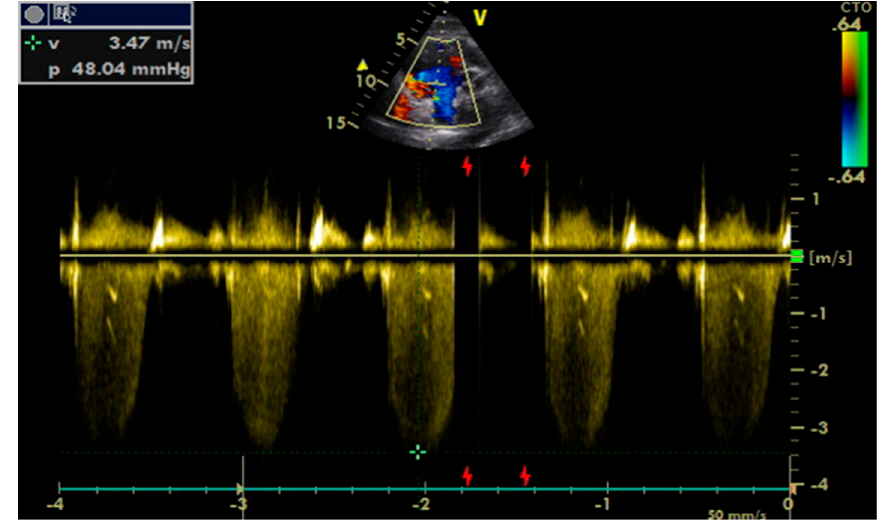
Figure 5. Echocardiographic assessment of tricuspid regurgitation peak velocity (TRpV) by continuous Doppler (CW) on tricuspid regurgitation jet. V: velocity; P: gradient (is 4V 2 ). V: specific echocardiographic parameter (it does not mean a measurement data).